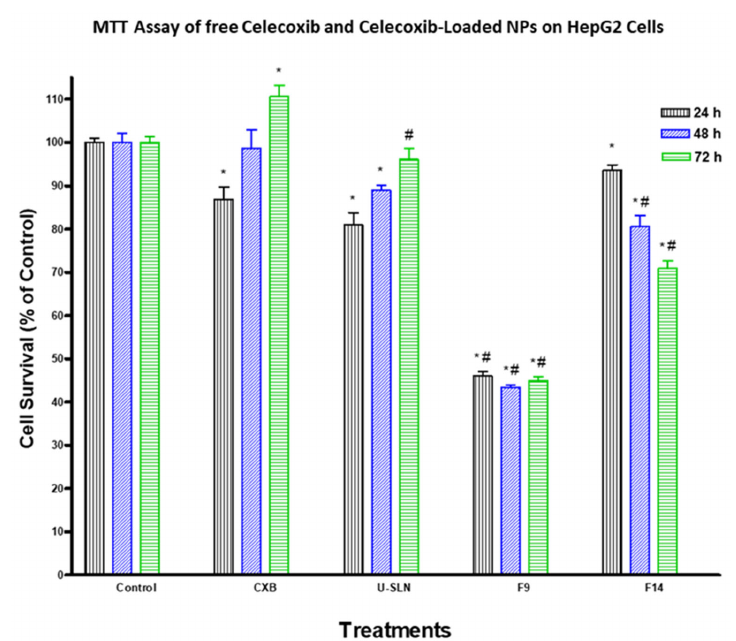
Figure 7. Effect of CXB and CXP–SLN on hepatocellular carcinoma cells. HepG2 cells were treated with indicated formulas of CXB–SLN (F9, F14), unloaded SLN, and pure CXB or buffer (control) for 24, 48 or 72 h. Cell viability was determined by MTT assay, as indicated in Section 2. At the end of the assay, an absorbance of 549 nm was read on a microplate reader. Significant differences between treatments and control and CXB were analyzed by ANOVA followed by t ‐ test. * p < 0.05 compared with control (0 μ M). # p < 0.05 compared with CXB.